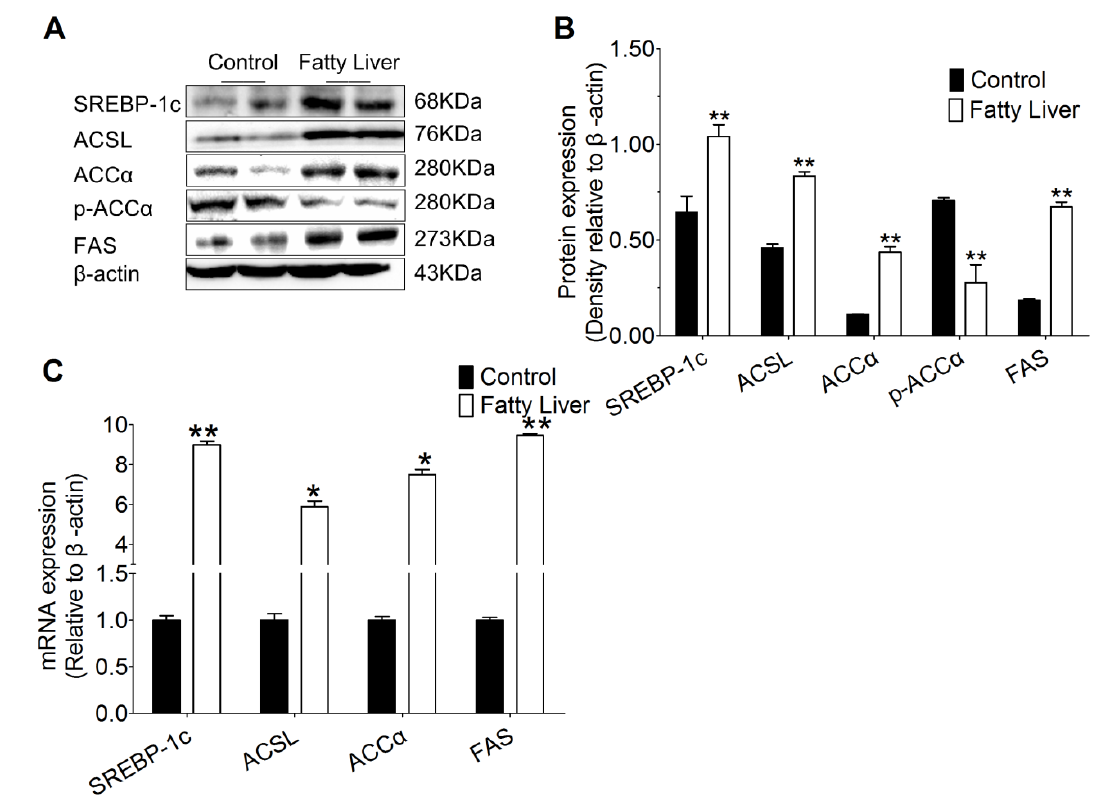
Figure 5. Lipid deposition enhances the hepatic lipogenesis pathway in the cow liver. ( A , B ) Protein levels of SREBP-1c, acyl-CoA synthetase long chain family member 1 (ACSL1), acetyl-CoA carboxylase alpha (ACC α ), p-ACC α and fatty acid synthetase (FAS) in control (n = 6) and fatty liver (n = 6) group dairy cows were determined by western blotting. ( C ) Total RNA was extracted from liver samples and the expressions of the genes involved in free fatty acid (FFA) and triglycerides (TG) biosynthesis in control (n = 6) and fatty liver (n = 6) group dairy cows were determined by real-time RT-PCR. The data presented are the mean ± SEM. * p < 0.05; ** p < 0.01.